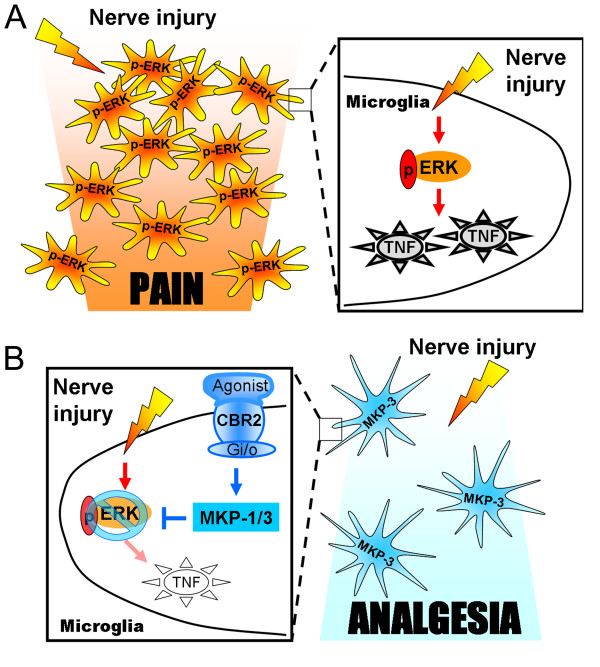
Proposed hypotheses. (A) Scheme of the proposed hypothesis on the mechanisms by which p-ERK induces a pro-inflammatory phenotype in microglia and contributes to neuropathic pain. Peripheral nerve injury increases microglial p-ERK in spinal cord dorsal horn, which in turn leads to the expression of TNF and an increase in microglial motility. These pro-inflammatory microglia migrate towards the spinal injured neuron area attracted by chemoattractants, such as ATP/ADP. The enhancement of pro-inflammatory microglia sensitizes spinal nociceptive neurons by increasing the concentration of pro-algesic factors, such as TNF. (B) Scheme of the proposed hypothesis on the mechanisms by which CBR2 activation-induced MKP-3 promotes an anti-inflammatory phenotype in microglia and alleviates neuropathic pain. Microglial CBR2 are increased in microglia following peripheral nerve injury. Microglial CBR2 activation induces an anti-inflammatory phenotype in microglia by increasing MKP-3 expression, which selectively inhibits p-ERK in spinal cord dorsal horn. Subsequently, ERK dephosphorylation results in a reduction of TNF expression and microglial motility. The reduction in the migration of pro-inflammatory microglia reduces the source of pro-algesic factors, such as TNF preventing neuronal sensitization and alleviating peripheral nerve injury-induced allodynia.